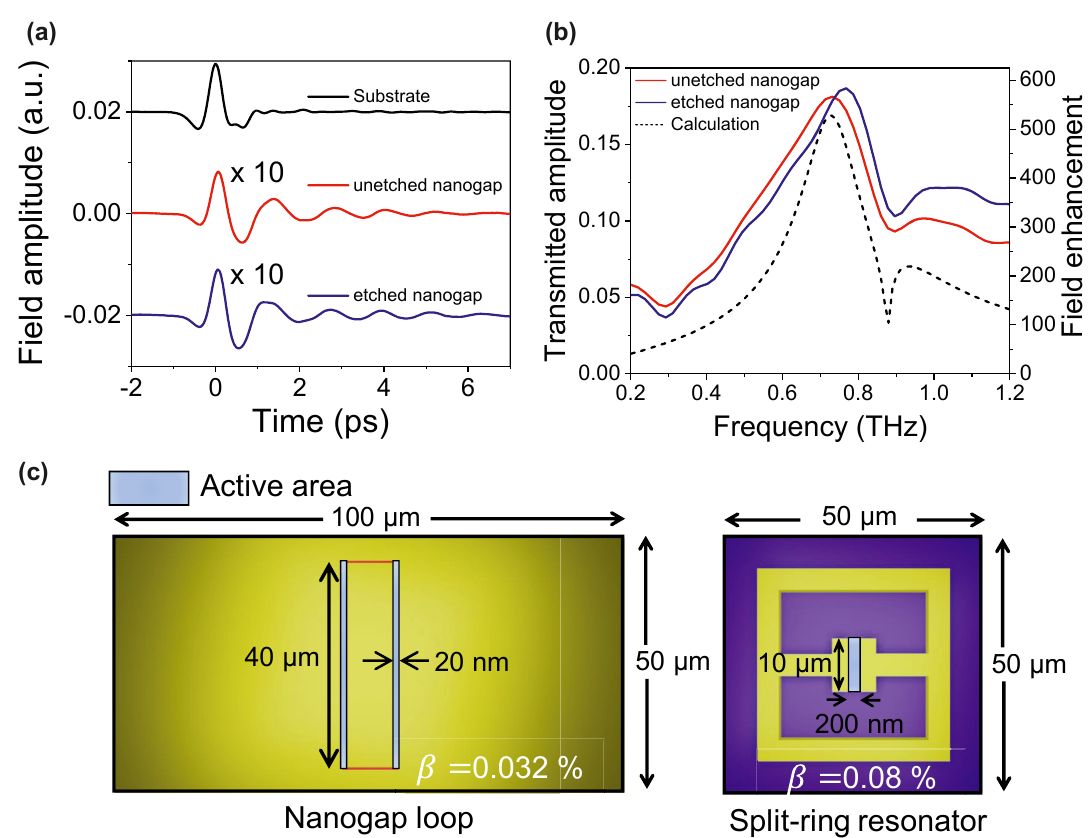
Figure 3: Terahertz time-domain spectroscopy of the gold nanogap-loop array. (a) Time-domain signals passing through a bare silicon substrate (black), the nanogap-loop array before (red), and after (blue) the etching process. (b) Fourier-transformed transmission amplitude and field enhancement spectra of the unetched (red) and the etched (blue) nanogaps. The black dashed curve shows the theoretical calculation using the modal expansion. (c) Schematic diagrams of the coverage ratio ( 𝛽 ) of the sensing area of the current nanogap-loop , and the split-ring resonator which was already reported